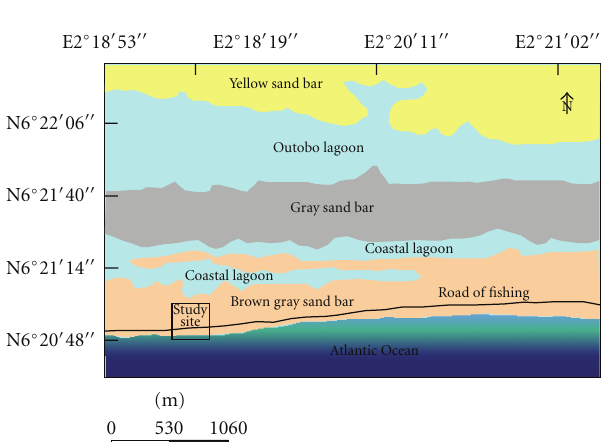
Figure 2: Map of sand bars in littoral